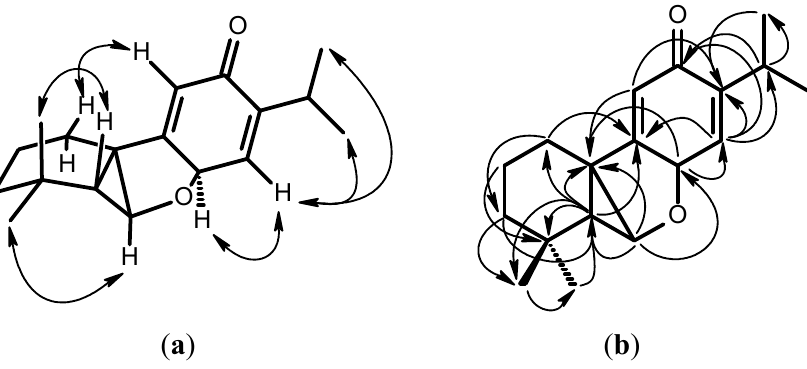
Figure 2. Key NOESY contacts ( a ) and HMBC connectivities ( b ) of compound 1